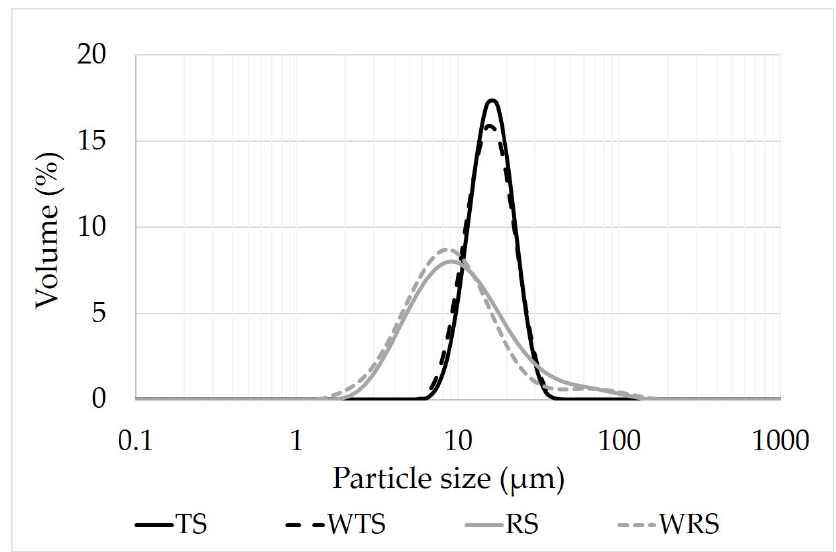
Figure 1. Particle size distribution of native starches.